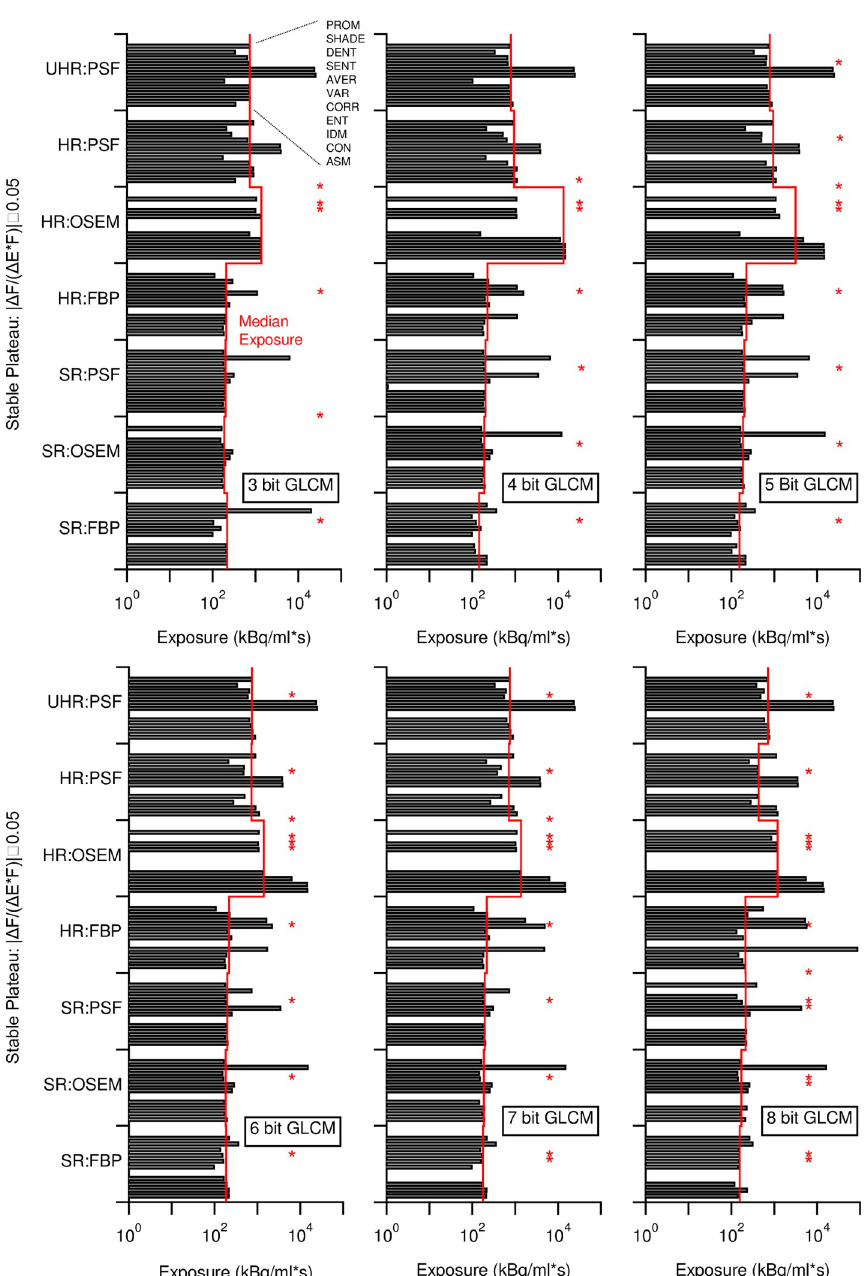
Fig 7. Onsets of stable plateaus in features calculated from differently quantized GLCMs with median exposure as a red line. � Missing values indicate stability over the entire exposure range. Textural feature order applies to all sets of image